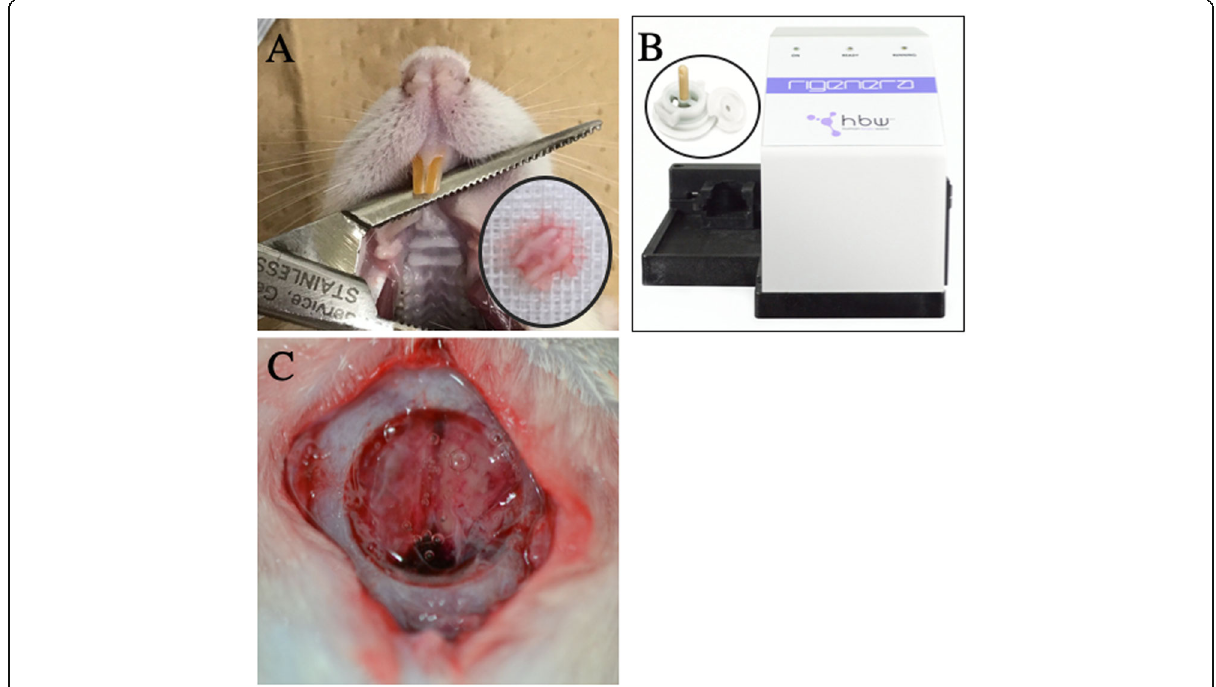
Fig. 1 Preparation of dissociated soft-tissue suspension. a Harvesting of rat palatal mucosa. b Use of the tissue dissociative machine (Rigenera; Human Brain Wave, Italy). c The dissociated soft-tissue suspension was mixed with self-assembling peptide and placed into the calvarial